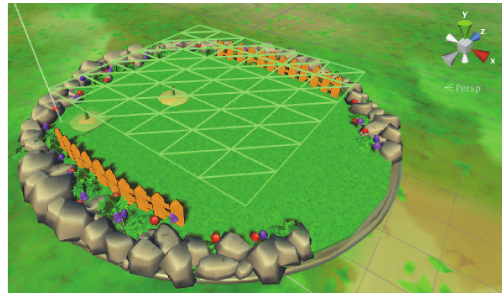
Figure 13: Gardening tools.